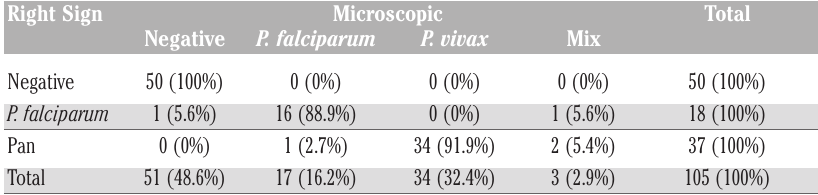
Table 5. Comparison of species detection between RightSign and microscopic.